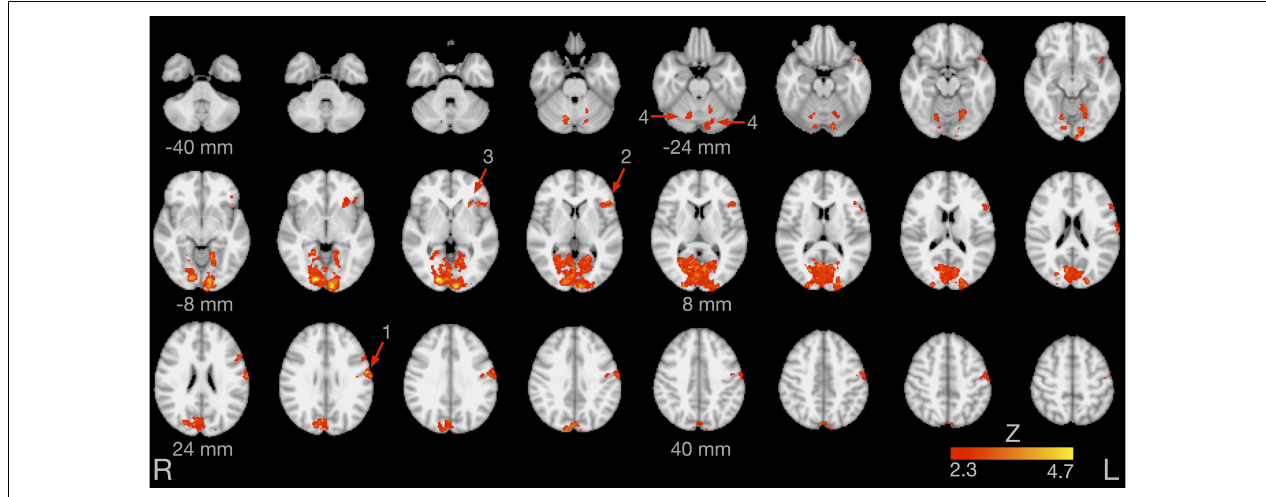
FIGURE 4 | Brain activity for the contrast English > German speech sound production. The arrows point at the left lateral sensorimotor cortex (1), left inferior frontal gyrus (2), left anterior insula (3), and bilateral cerebellar lobule VI (4). Images are in radiological convention (the left hemisphere is seen on the right).